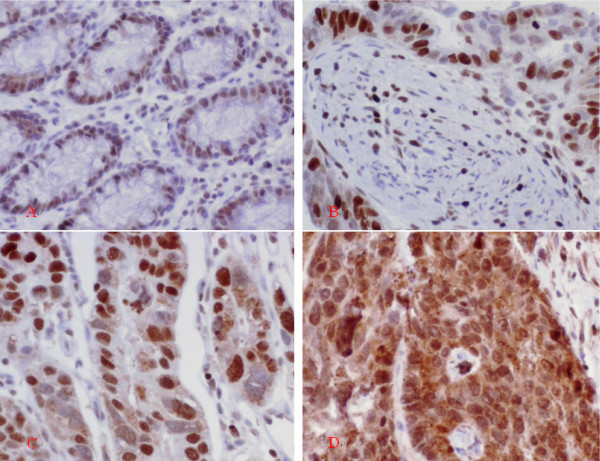
Immunohistochemical detection of HMGB1 protein in different gastric tissues. A: Normal rectal sample. The low-expression of HMGB1 was detected in epithelial and stromal cells B: Gastric adenocarcinoma sample with well differentiation. The immunohistochemical staining showed strong positive signal (+ + +) in the cancer cells, and low-expression was detected in the stromal cells, which localized in the nucleus. C: Gastric adenocarcinoma sample with poor-moderate differentiation. The immunohistochemical staining showed strong positive signal (+ + +), which mainly localized in the nucleus. D: In rare cases, the strong staining was detected in the nucleus and cytoplasm of the cancer cells. Original magnification × 200.